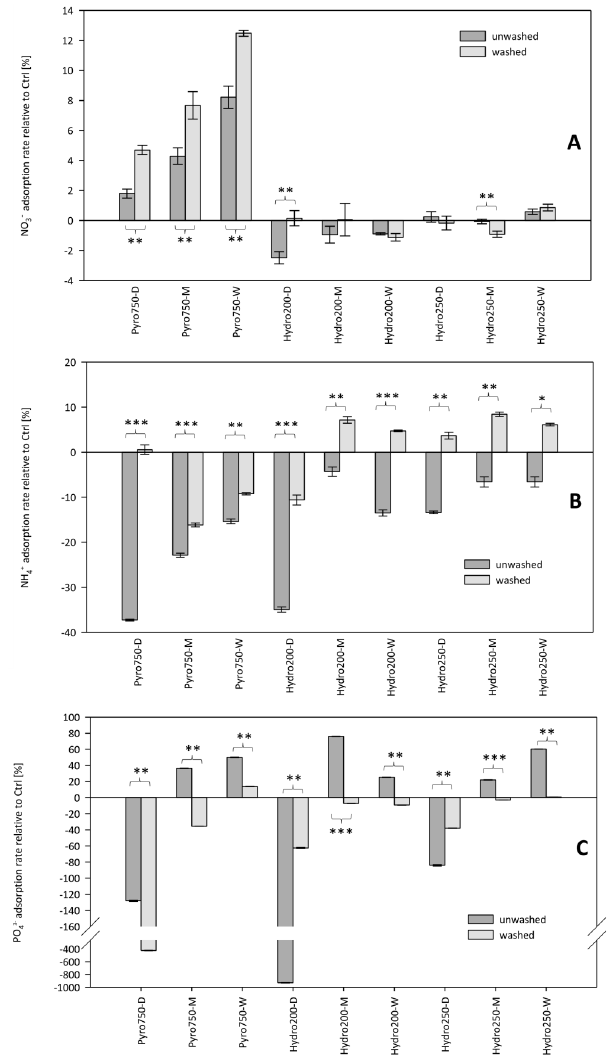
− , (b) NH + , and (c) PO 3 − removal rates in soil– Figure 5. (a) NO 3 4 4 char composites relative to the control (silt loam without char) for washed and unwashed pyrochars (Pyro750) and hydrochars derived at 200 ◦ C (Hydro200) and 250 ◦ C (Hydro250) from Miscanthus (M), woodchips (W), and digestates (D). Significant differences be- tween washed and unwashed chars were tested with the unpaired t test. p values are indicating by *** <0.01, ** <0.05, and * <0.1 (for each treatment n = 3, means ±